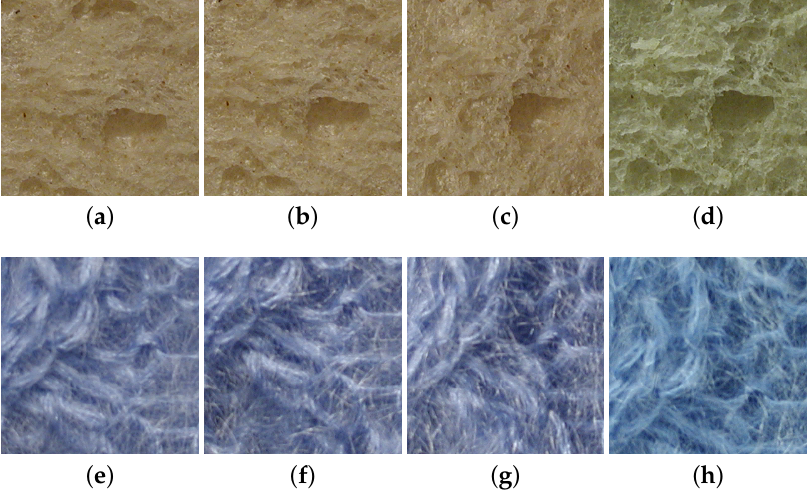
Figure 3. Changes in visual appearance of a white bread sample and a wool sample from the KTH- TIPS2 dataset under various lighting and viewing directions. Images ( a – d ) were captured with a frontal viewing direction and frontal, 45° from the top, 45° from the side, and ambient illumination conditions, respectively, for a white bread sample. Similarly, images ( e – h ) were captured with a frontal viewing direction and frontal, 45° from the top, 45° from the side, and ambient illumination conditions, respectively, for a wool